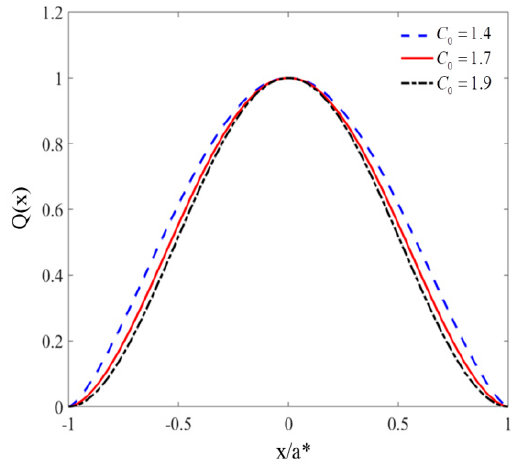
Figure 13. One-dimensional spatial distribution shape of impact load.